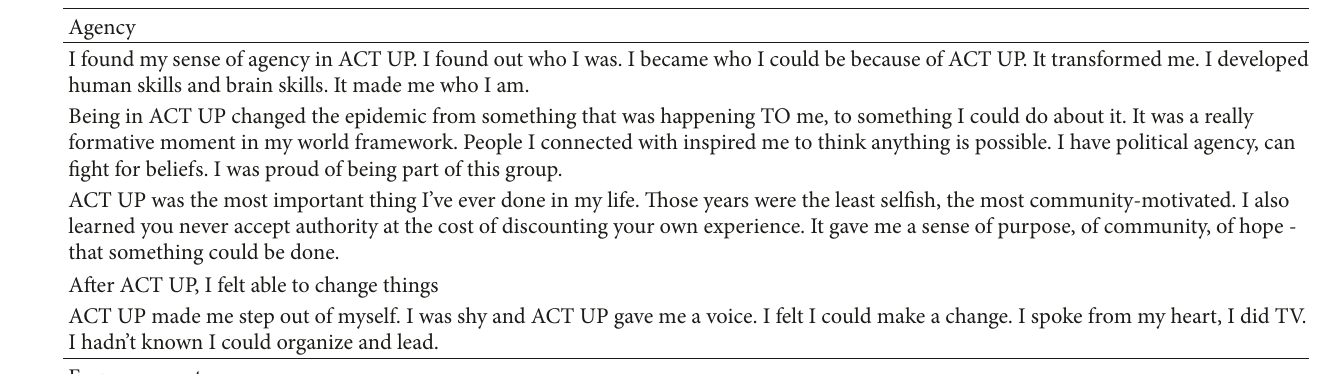
Table 6: Major categories of response to the question, “Do you think being in ACT UP changed your sense of self, who you are as a person?”